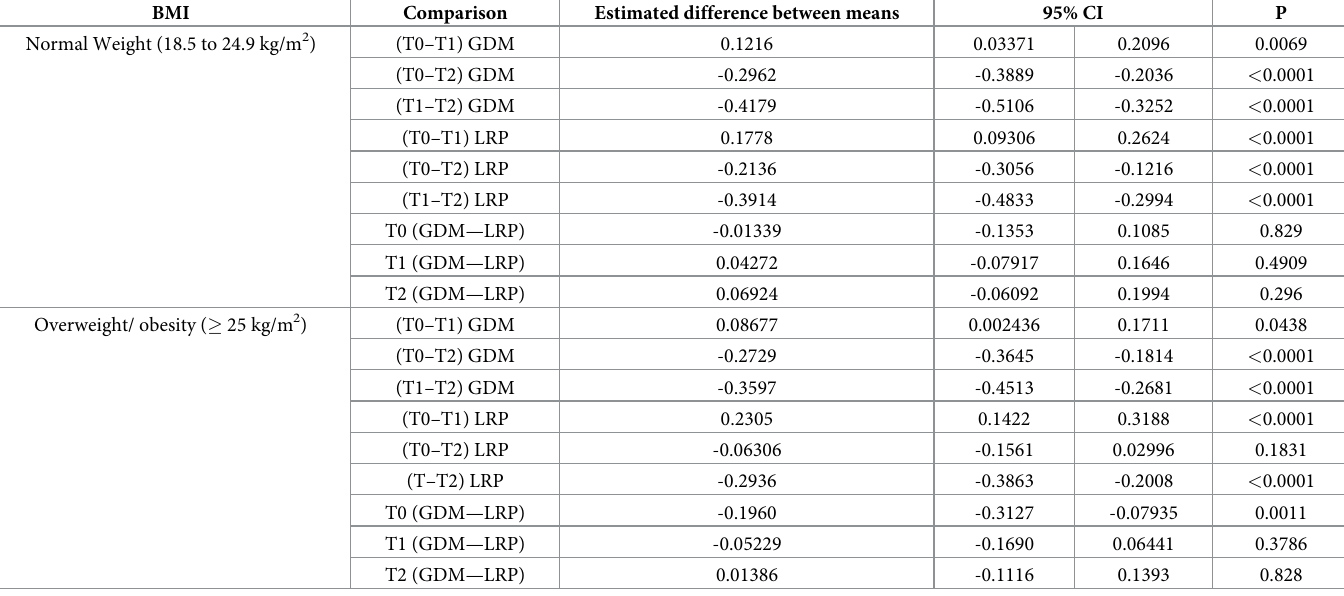
Table 3. Estimated difference between means for comparisons between time points and between groups in each body mass index category (N = 321). BMI Comparison Estimated difference between means 95% CI P Normal Weight (18.5 to 24.9 kg/m 2 )